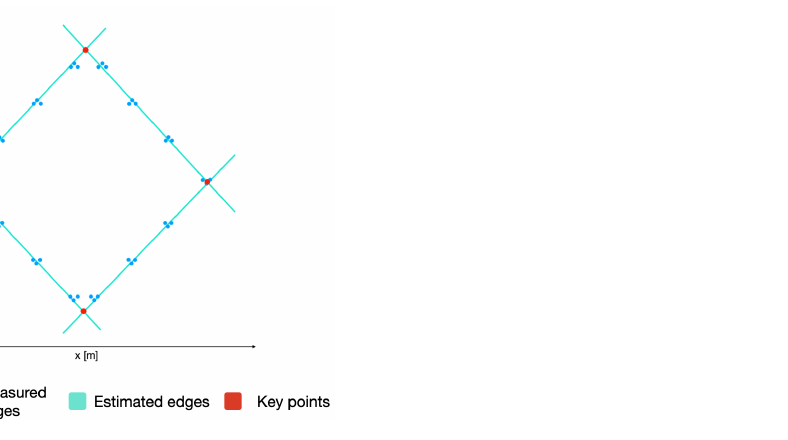
Figure 10. 3D points belonging to the calibration point, the corresponding estimated edges, and the resulting key points.